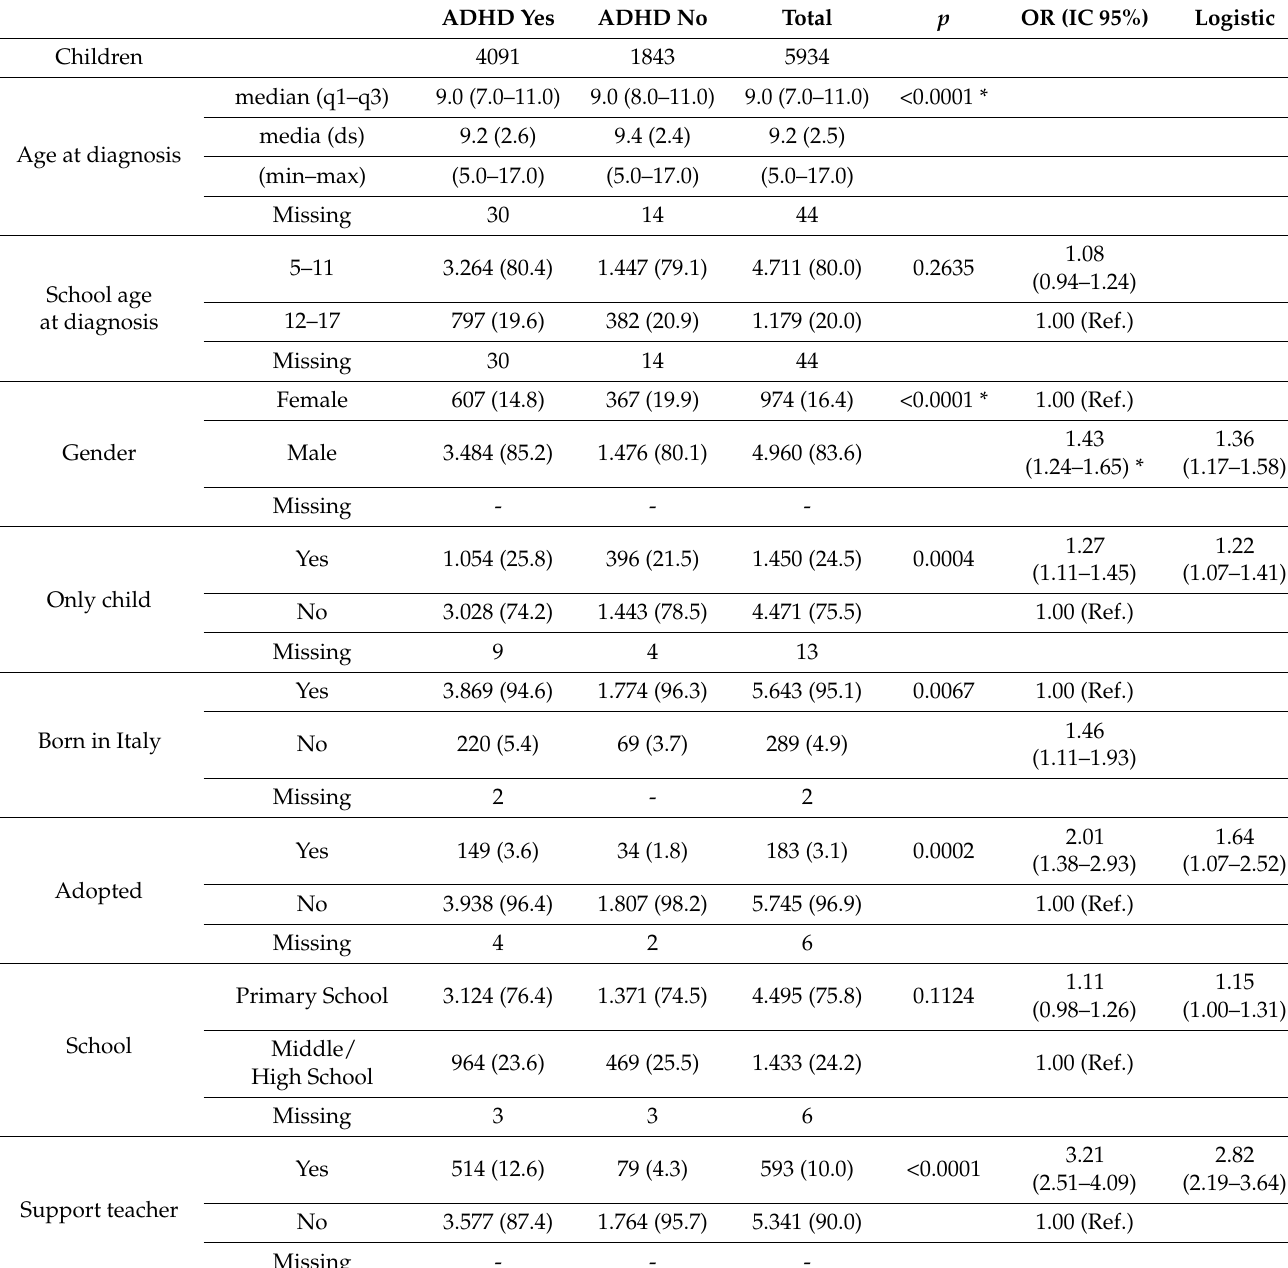
Table 1. Demographic characteristics of the ADHD